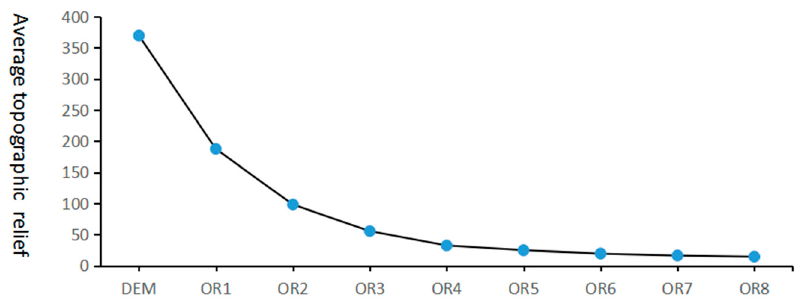
Figure 5. Variation curve of the average topographic relief with topographic decomposition.